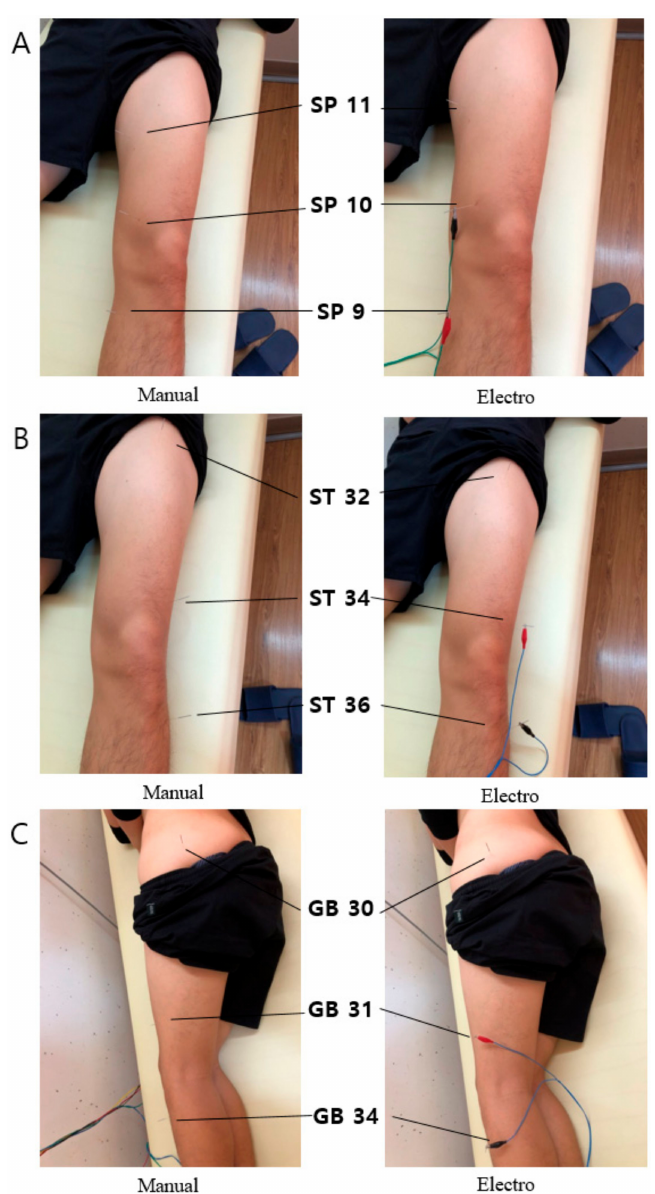
Figure 3. Acupoint options. The pictures in the left column are manual acupuncture and the right column are electroacupuncture. ( A ). SP9, SP10, and SP11, ( B ). ST32, ST34, and ST36, ( C ). GB30, GB31,